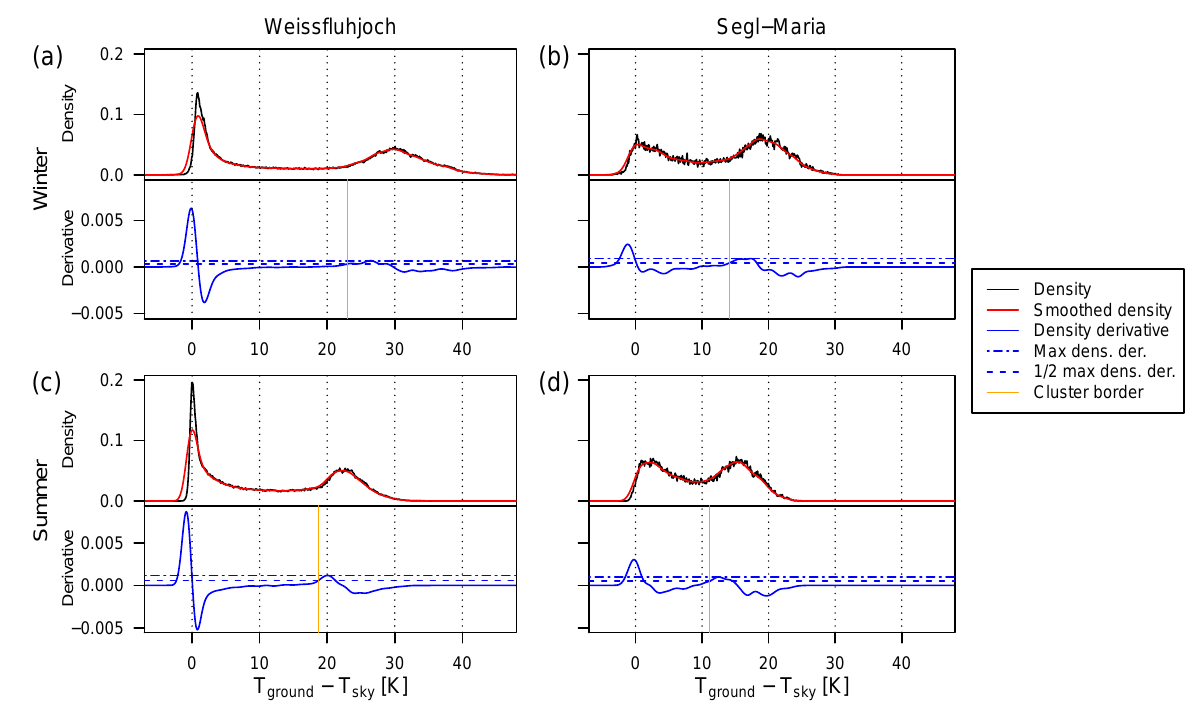
Figure 7. Detection of the longwave lower cluster on daytime data, at two different stations ( a , b : Weissfluhjoch; b , d : Segl-Maria; 1 year of measurements), for winter (a, b) and summer (c, d)